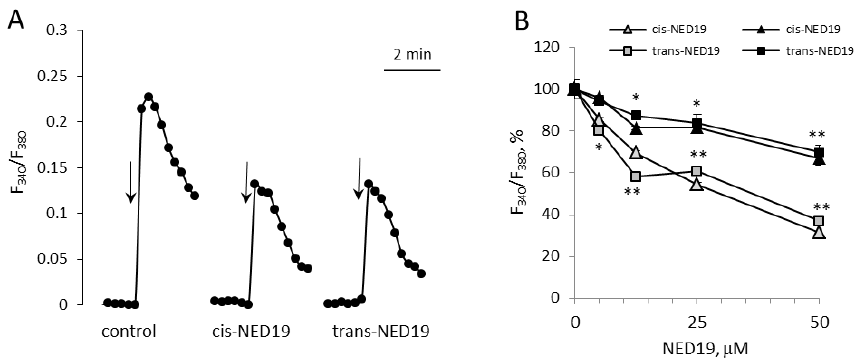
Figure 5. Decrease by cis - and trans -NED 19 of histamine-induced [Ca 2+ ] i elevation in HUVECs. ( A ) The kinetics of [Ca 2+ ] i rises in response to 1 μM histamine in the absence and presence of 25 μM cis - or trans -NED19; the arrows indicate histamine addition. ( B ) The effects of different concentrations of cis -NED 19 (triangles) and trans -NED 19 (squares) on [Ca 2+ ] i elevation in response to histamine at 1 μM (open triangles and squares) and 10 μM (black triangles and squares) concentrations. The values in panel B are the means of three to six independent measurements + SEM. There is a significant difference between control and experimental points (* p < 0.05, ** p < 0.01).